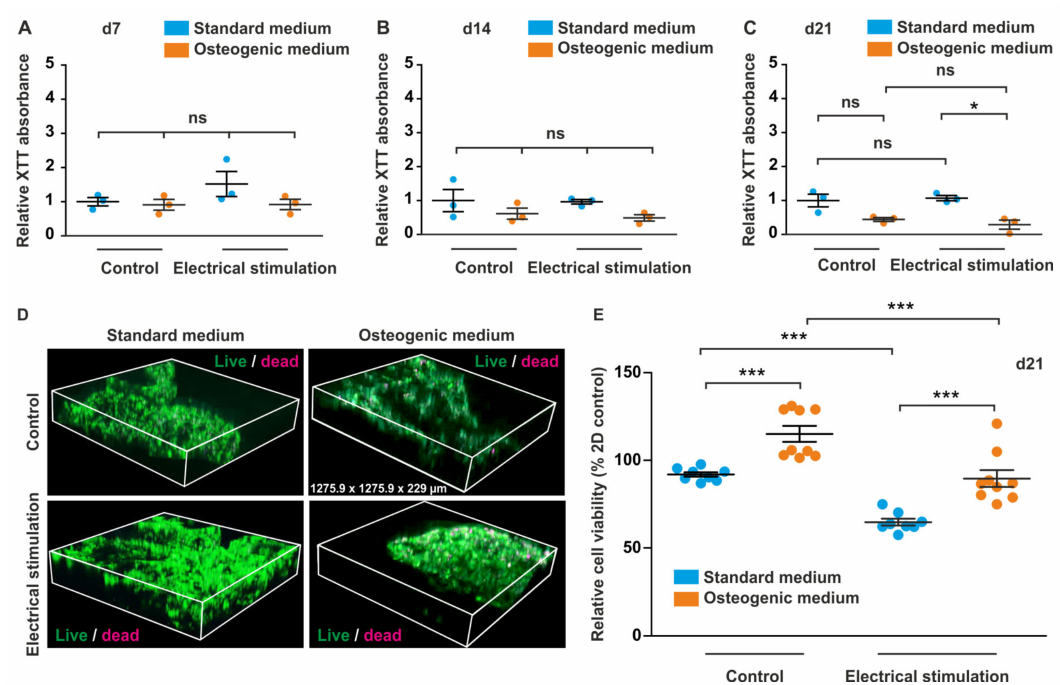
Figure 4. Electrical stimulation (ES) only moderately decreases viability of adipose-derived stem cells (ASCs) in 3D under osteogenic cultivation conditions. ( A – C ) Assessment of viability using XTT assays. ASCs embedded into 0.2% aNFC hydrogels were exposed to ES in standard and osteogenic medium for up to 21 days followed by assessment of viability using XTT assays. No significant di ff erences in viability were detected at d7 and d14, whereas a slight but significant decrease was observed in cells exposed to ES in osteogenic medium compared to cells in standard medium with ES. ( D , E ) Calcein / ethidium homodimer-1 based live dead assay. Cells were cultivated in standard or osteogenic di ff erentiation medium with or without ES for 21 days followed by a live / dead assay, and confocal laser scanning microscopy with subsequent 3D reconstruction. Data analysis revealed higher relative viability in 3D cells in osteogenic di ff erentiation medium compared to control cells in aNFC and a higher relative viability in cells subjected to osteogenic di ff erentiation and ES compared to cells in 3D with ES. Error bars: SEM. * p < 0.05, *** p < 0.0001. ns: not